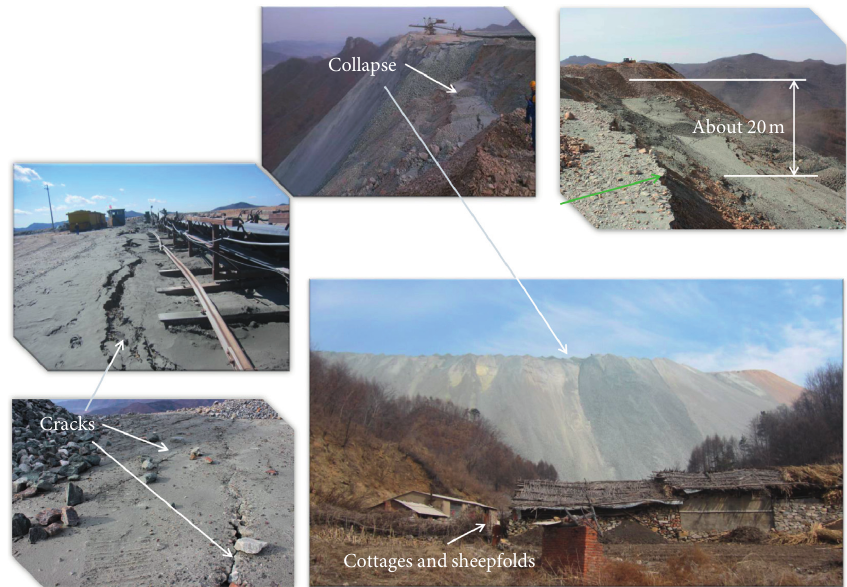
Figure 6: Collapse and cracks in the top area of the dump before